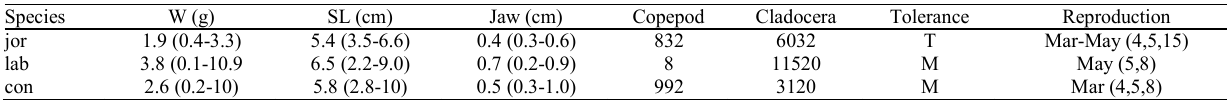
Table 1. Chirostoma species biometrics and life strategies characteristics. Abbreviations are: Chirostoma jordani (jor), C. labarcae (lab) C. consocium (con) weight (W; average, maximum-minimum), standard length (SL; average, maximum-minimum), jaw length (Jaw; average, maximum-minimum) and March (Mar; sample sites). Number of individuals of copepods and cladocerans found on the diet. Tolerance: Tolerant (T) and medium tolerance